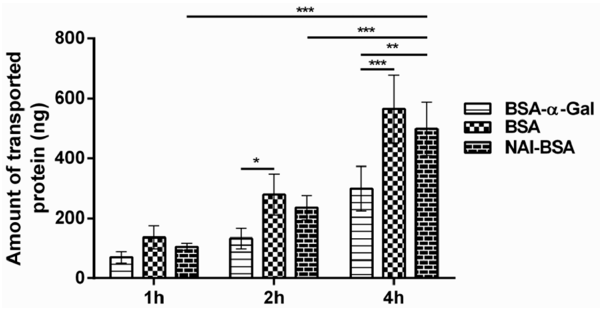
Figure 3. Comparison of transcytosis of BSA- α -Gal, BSA, and N-acetyllactosamine (NAl) conjugated to BSA (BSA-NAl) through the Caco-2 monolayer, n = 4, * p < 0.05, ** p ˂ 0.01 and *** p < 0.001 analyzed by two-way ANOVA with Bonferroni’s post hoc